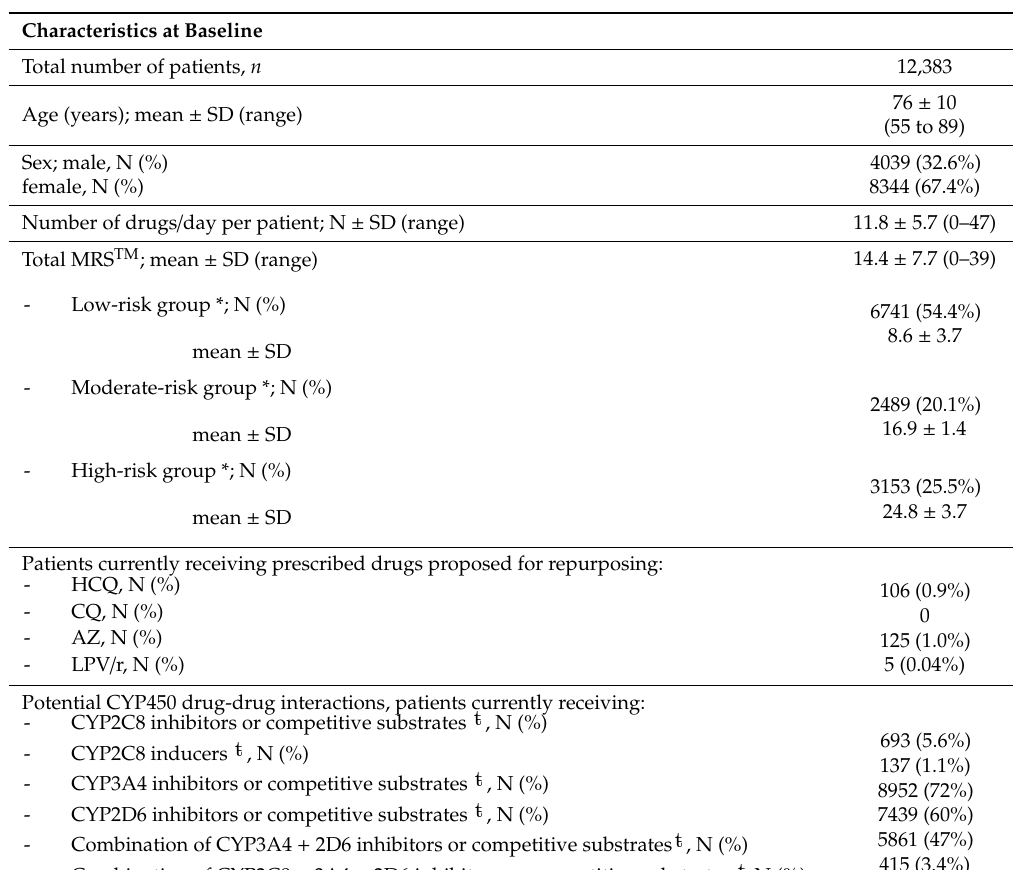
Table 1. Demographic characteristics of the studied population.